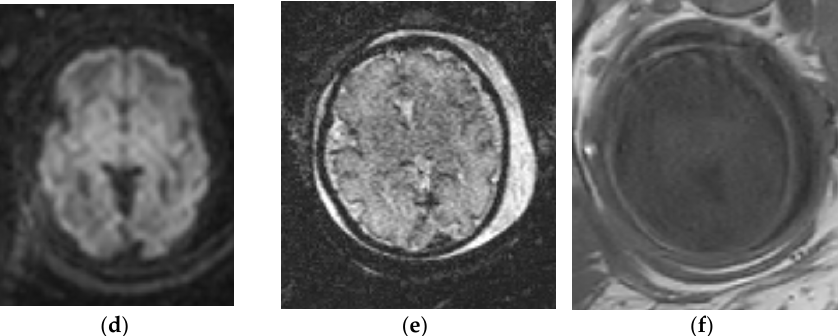
Figure 1. Fetal brain MRI protocol. Normal brain MRI in a 32-week, 6-day GA fetus. Sagittal ( a ), axial ( b ) and coronal ( c ) T2-SSFSE images in brain are used to evaluate brain parenchyma signal and morphology. Axial DWI ( d ) can be used to look for cerebral infarction. Axial EPI ( e ) allows for eval- uation of intracranial hemorrhage with a greater sensitivity. Axial T1-weighted image ( f ) has limited spatial resolution however can be helpful to evaluate for intracranial lipoma, hemorrhage or throm- bosis.